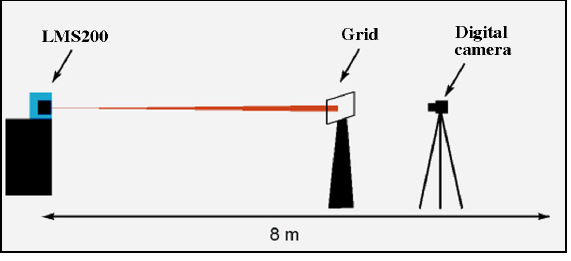
Figure 2. Set up for visualisation of the laser beam.